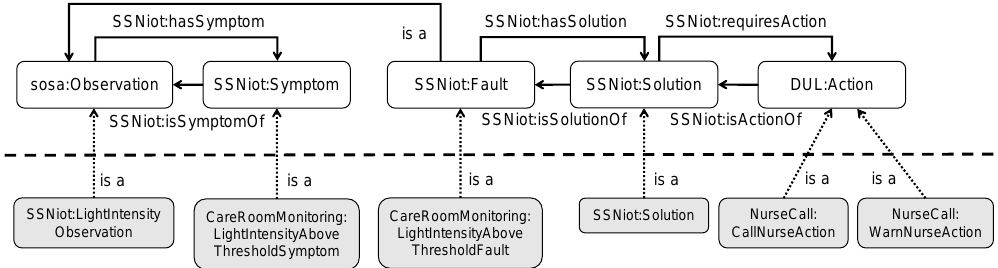
Figure 4. Overview of the most important ontology patterns and related classes of the Proof-of-Concept use case. The example for light intensity is given; the classes and patterns for sound are